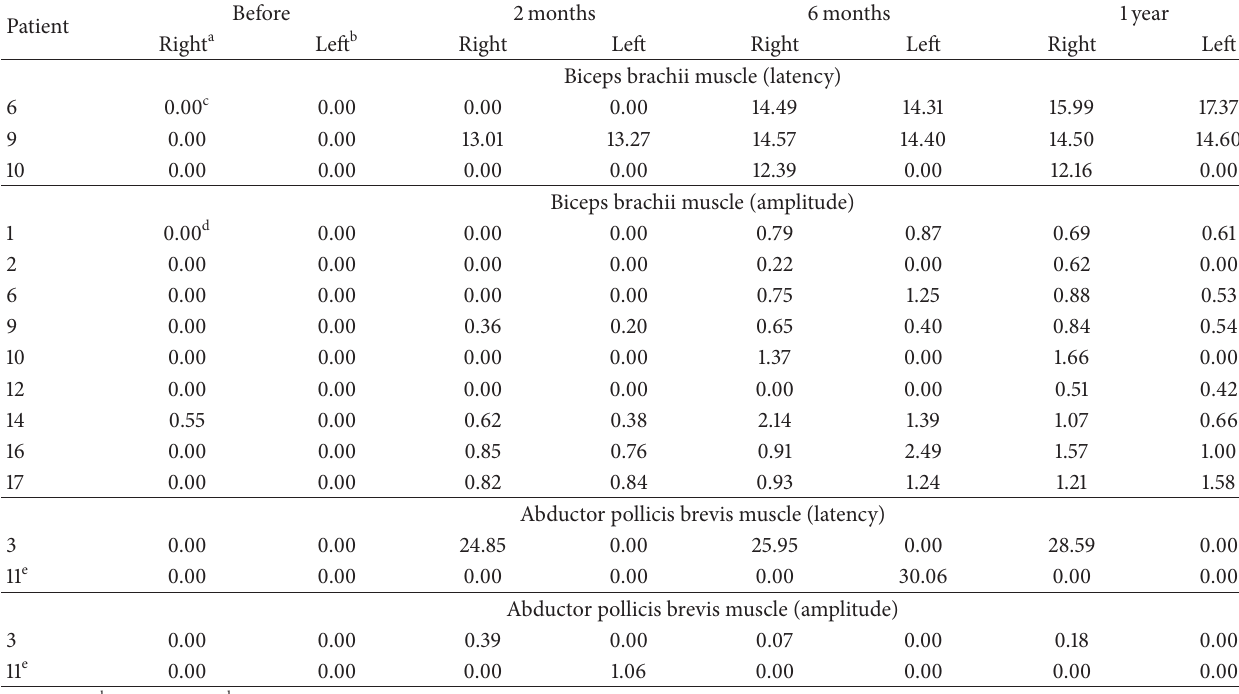
Table 11: Latency and amplitude measured by evoked potentials of the upper limbs in patients with cervical SCI who showed response of MEP over 1 year after hNSPC transplantation.